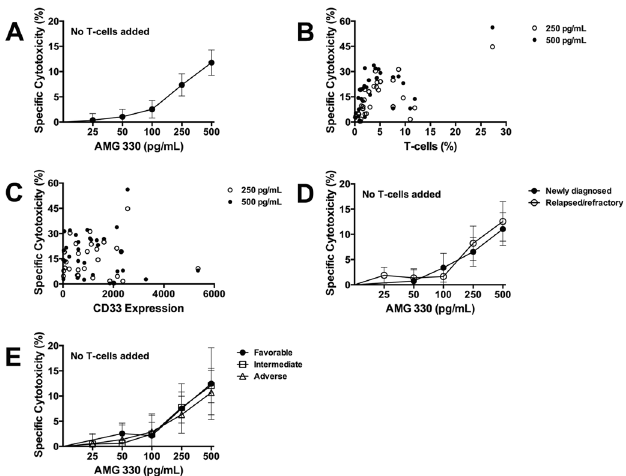
Fig 1. AMG 330-induced cytotoxicity without addition of healthy donor T-cells. (A) 41 primary AML specimens were incubated with increasing concentrations of AMG 330. After 48 hours, cell counts were determined and cytotoxicity was assessed with DAPI staining to quantify drug-specific cytotoxicity. Results are shown as mean ± SEM. (B) Relationship between percentage of autologous T-cells and AMG 330-induced cytotoxicity. (C) Relationship between CD33 expression on leukemic blasts (expressed as arbitrary fluorescence intensity) and AMG 330-induced cytotoxicity. (D) AMG 330-induced cytotoxicity, stratified by disease stage (newly diagnosed AML [n = 21] and relapsed/refractory AML [n = 20]). Results are shown as mean ± SEM. (E) AMG 330-induced cytotoxicity, stratified by disease risk (favorable-risk [n = 5]; intermediate-risk [n = 26]); and adverse-risk [n = 10]). Results are shown as mean ±